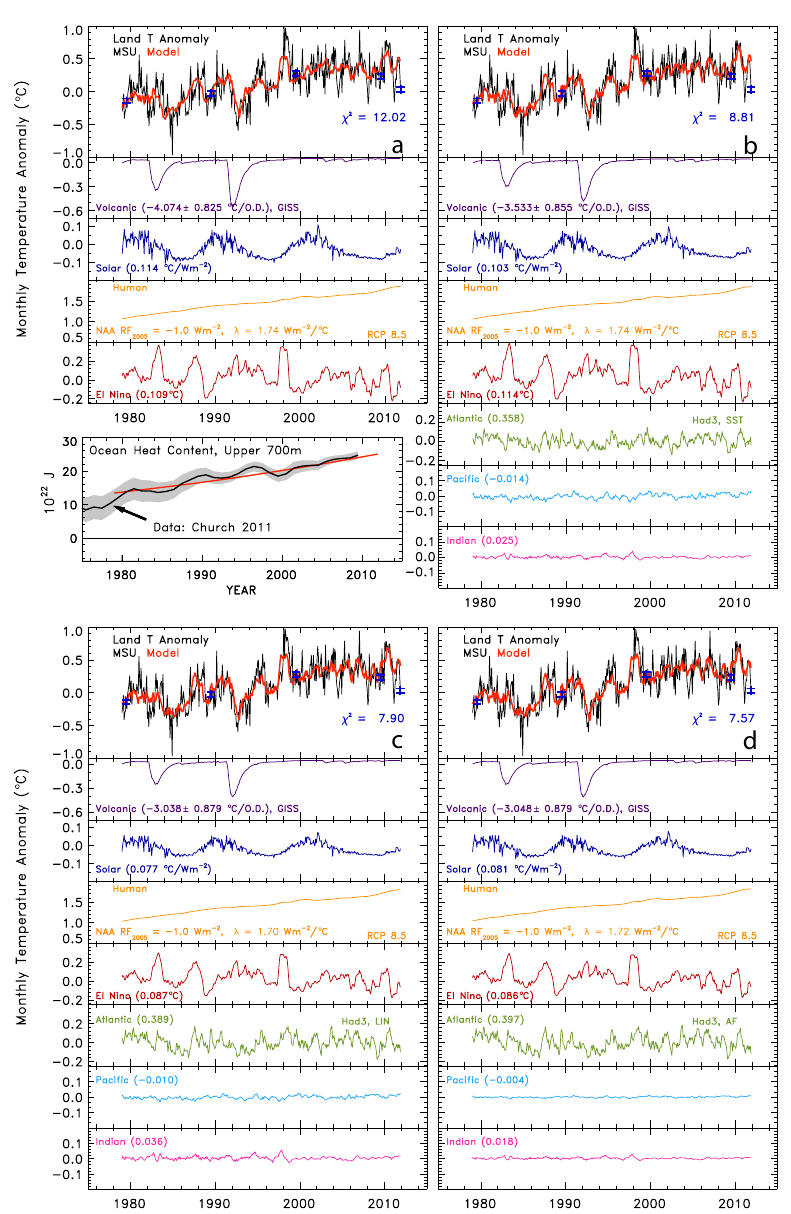
Fig. 14. Same as Fig. 11, but for the MSU land, monthly mean lower troposphere temperature